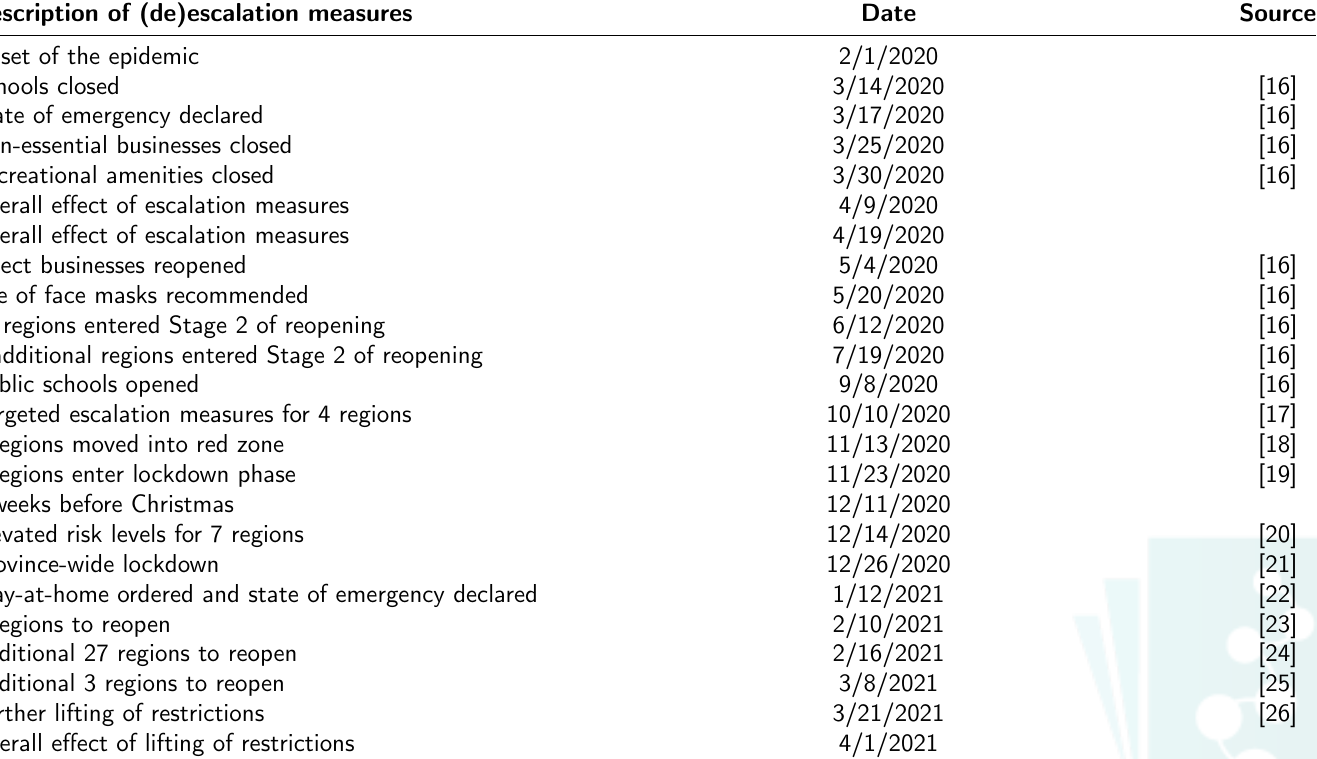
Table A2.7: Timeline of major policies in Ontario, Canada from 1 st February 2020 to 1 st April